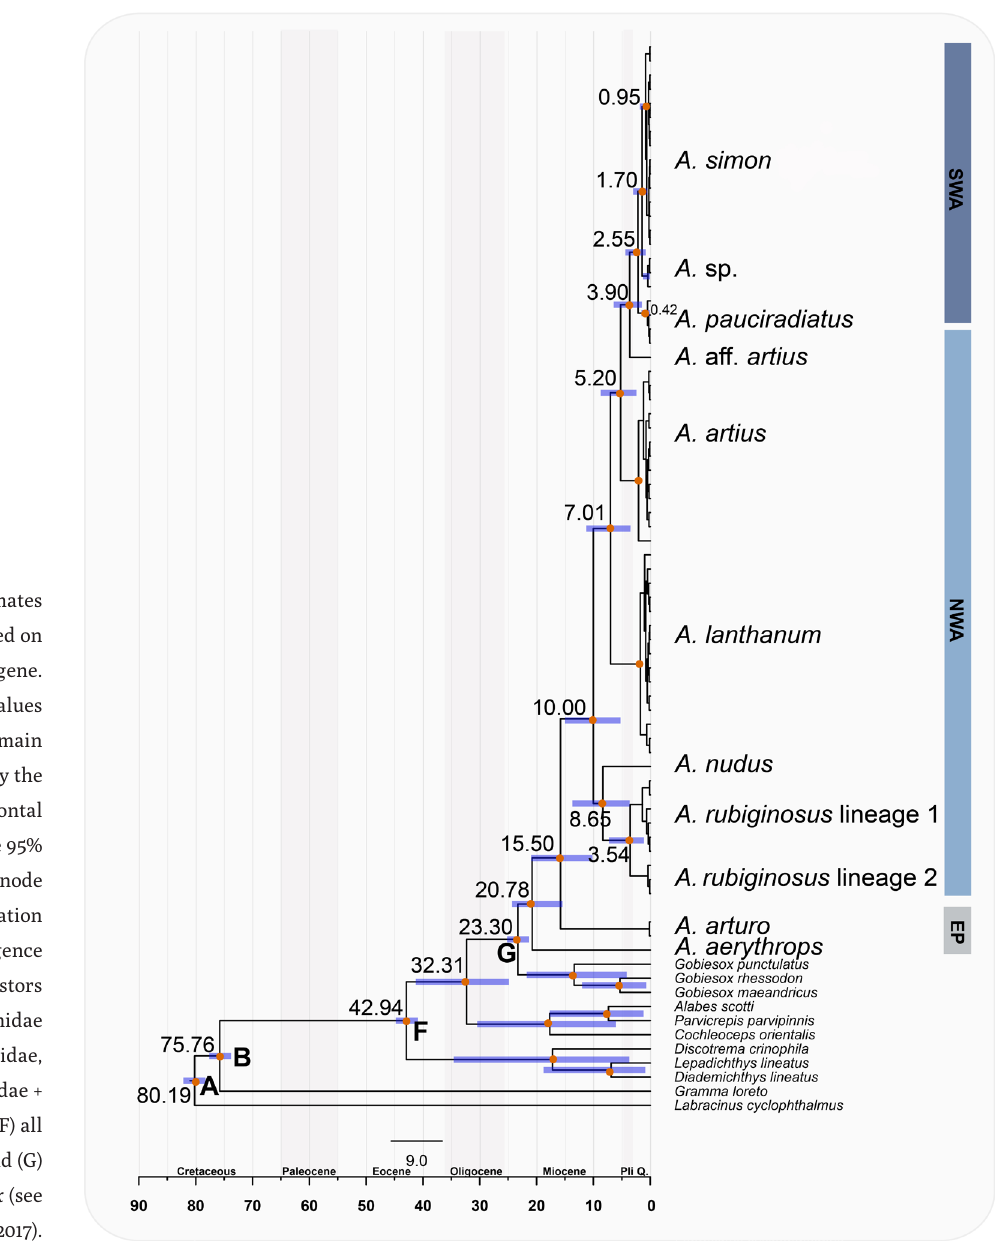
FIGURE 4 | Bayesian estimates of divergence time based